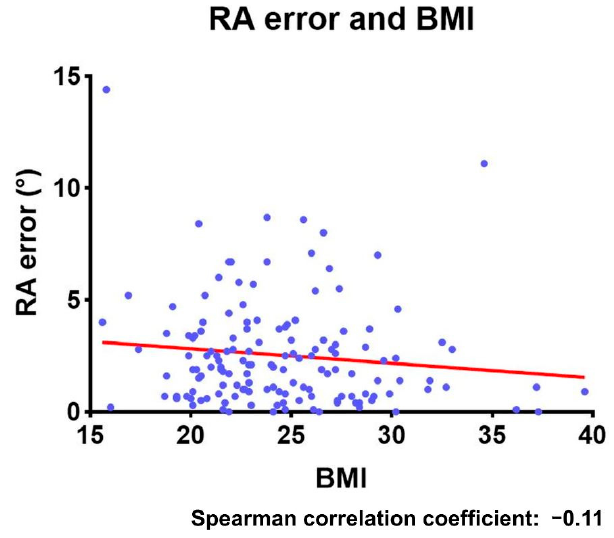
Figure 4. The relationship between the RA error and the patient’s BMI. RA: radiographic anteversion; BMI: body mass index.